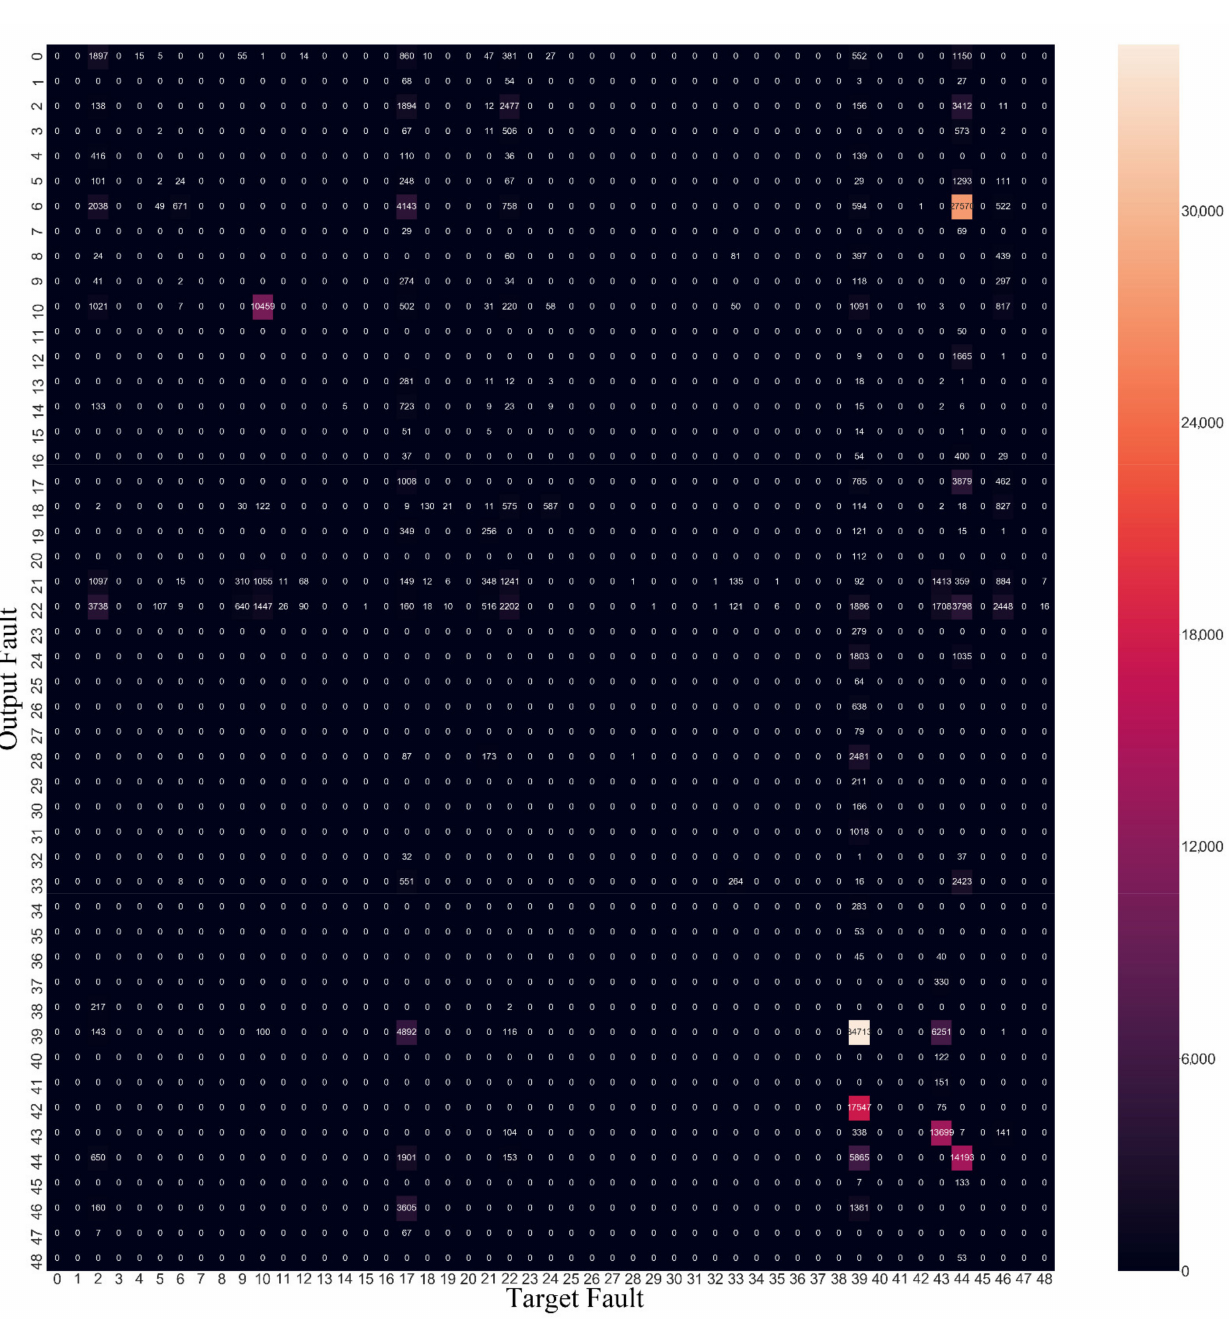
Figure 9. Confusion matrix of